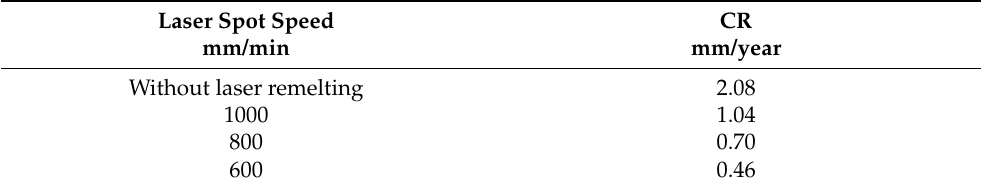
Table 5. Corrosion rate of the Cr 3 C 2 -25(Ni20Cr) cermet coatings on the Al7075 substrate without and with laser